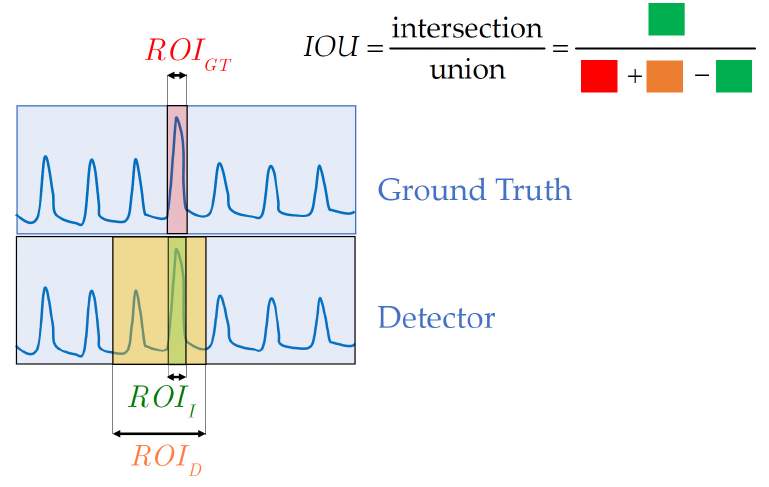
Figure 9. Method of obtaining the intersection over union (IOU) in signals. Colors boxes in the formula indicates the different regions of interest (ROI), according to the figure on the left.